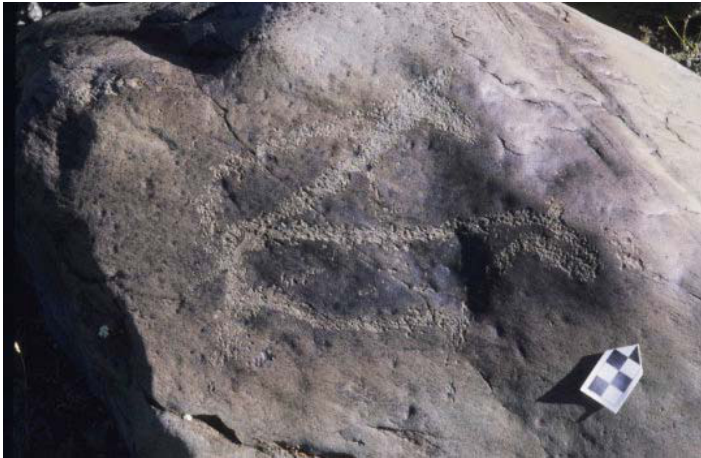
Figure 12. Two horses, contoured. Pre-Bronze Age (Paleolithic period). Baga Oigor II. (http://oregondigital.org/u?/maic,2809).